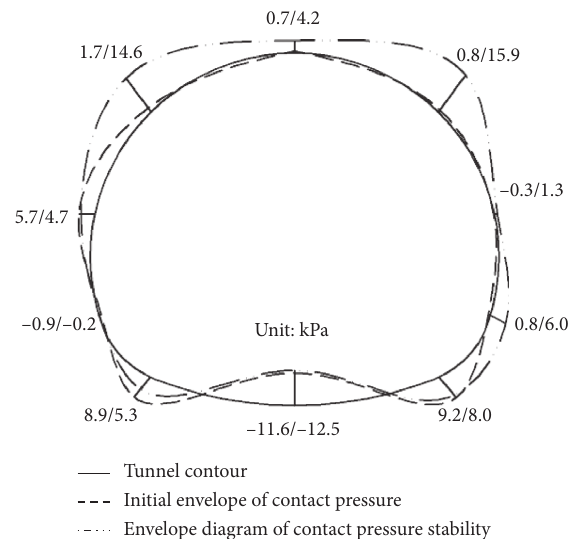
Figure 18: DK-190+645 mileage concrete internal force envelope diagram of Zaosheng